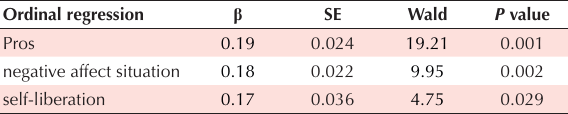
Table 4. Predictors of stage transition to helmet use in motorcyclists of Ardabil city Ordinal